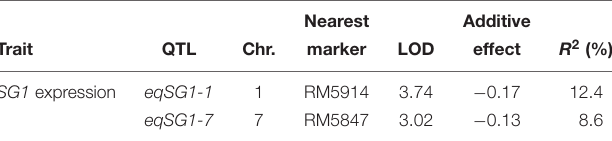
TABLE 2 | Expression QTLs (eQTLs) for the short grain 1 ( SG1) gene detected in the BILs.